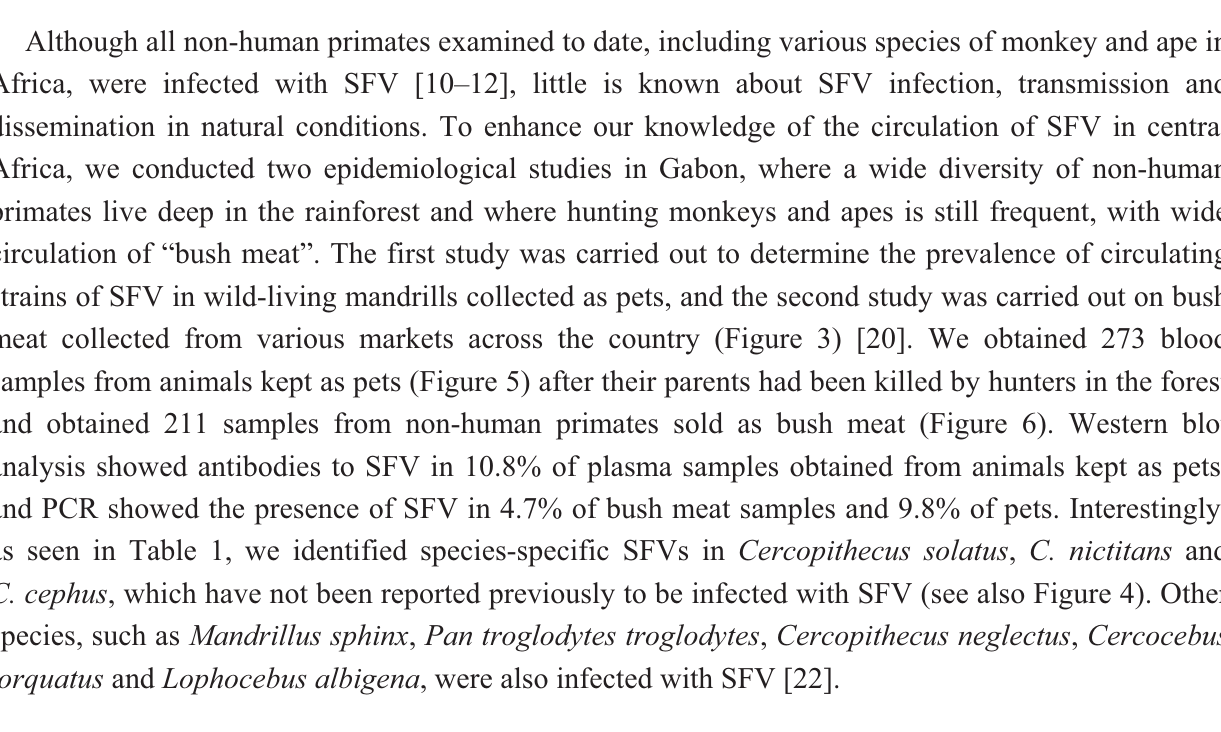
Figure 5. A chimpanzee and monkeys kept in various villages as pets after their parents had been killed by hunters in the forest. ( A ) Pan troglodytes troglodytes (chimpanzee); ( B ) Mandrillus sphinx (mandrill); ( C ) Cercopithecus solatus (sun-tailed monkey); ( D ) Cercocebus torquatus (red-capped mangabey); ( E ) Miopithecus ogoouensis (Gabon talapoin) and ( F ) Cercopithecus cephus (moustached